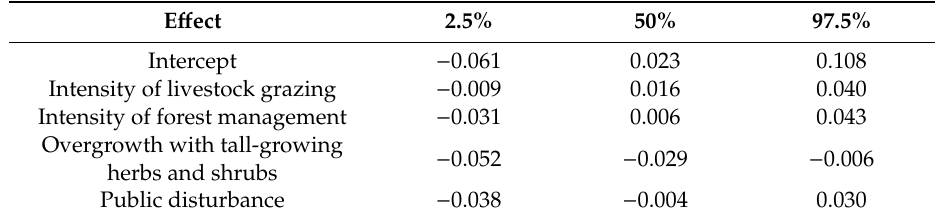
Table 4. The percentiles of the marginal distribution of the estimated posterior distribution of the e ff ect of the mean estimated pressures at each site on the site-specific random time coe ffi cients, δ i , of model 2. E ff ect 2.5% 50% 97.5% Intercept − 0.061 0.023 0.108 Intensity of livestock grazing − 0.009 0.016 0.040 Intensity of forest management − 0.031 Overgrowth with tall-growing − herbs and shrubs